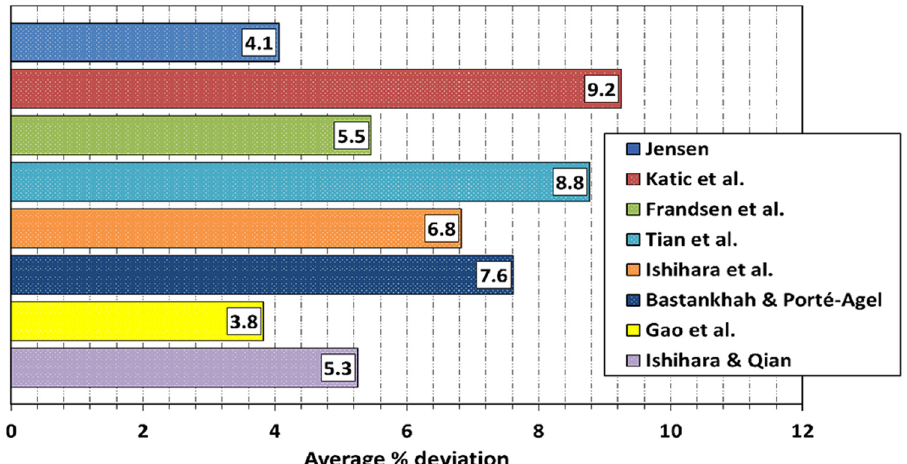
Fig. 9. Average percentage deviation of each wake model in the entire far-wake region for upstream wind speed value equal to 13